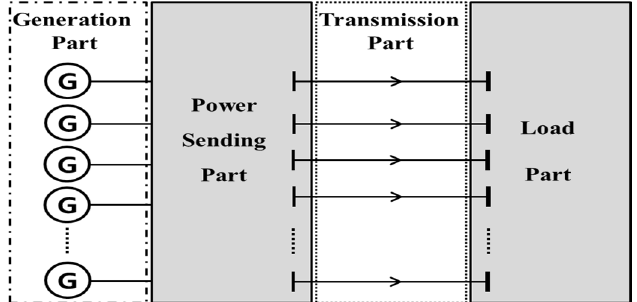
Figure 1. Conceptual diagram of power system divided into four groups.